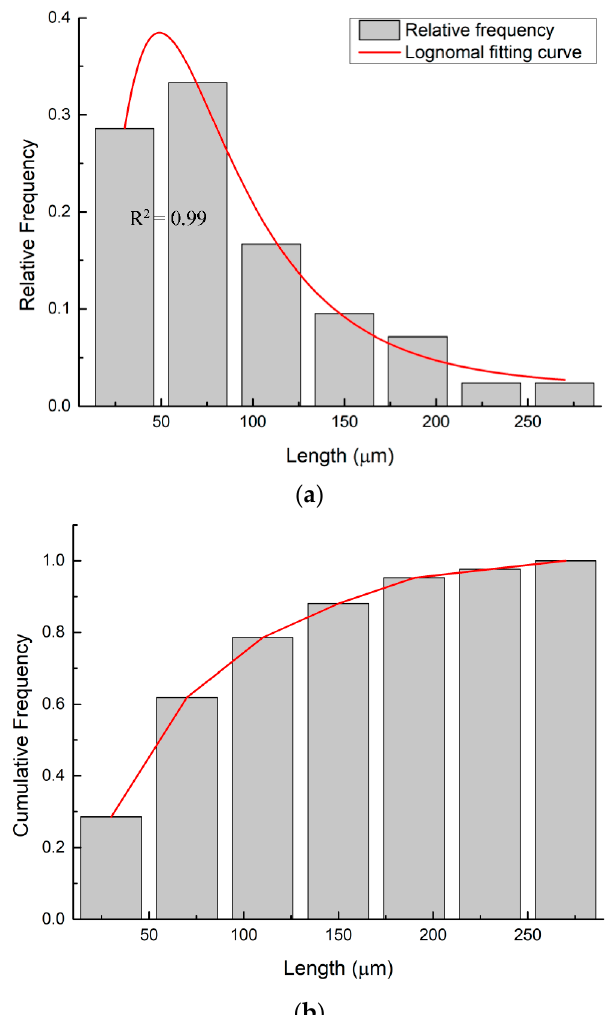
Figure 6. Length frequency histogram of the microcracks on the newly produced PF. ( a ) Relative frequency. ( b ) Cumulative frequency.